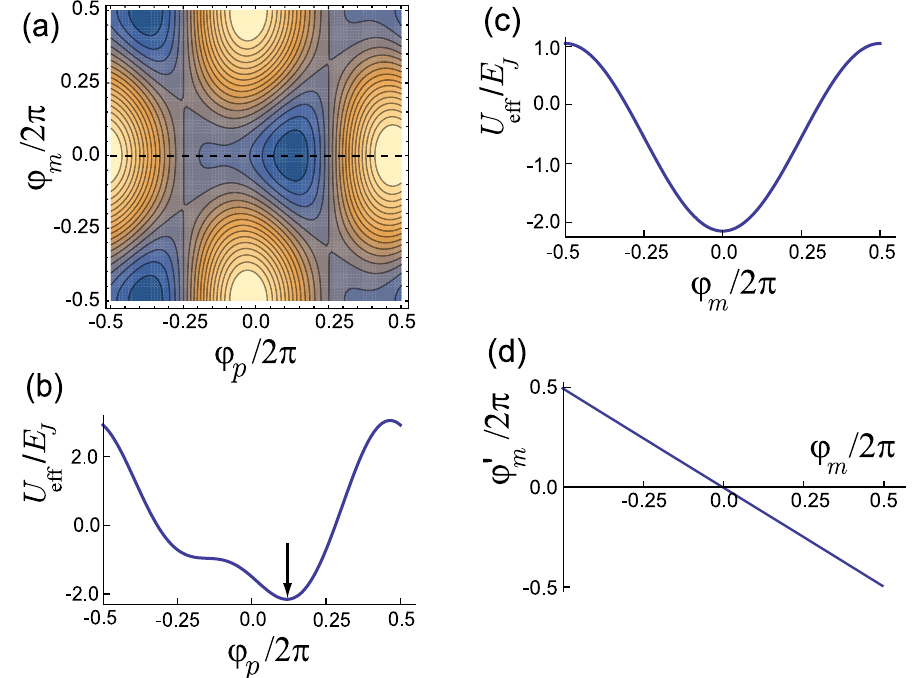
Figure 2. ( a ) Contour plot for the effective potential U eff for the system in Fig. 1b as a function of ϕ p and ϕ m for f 1 = f = 0.42, and f 2 = f 3 = 0 . ( b ) Profile of U eff along the dotted line in ( a ) for ϕ m = 0 . At ϕ p / 2 π ≈ 0.124 U eff has the minimum. ( c ) The profile of U eff for ϕ p / 2 π ≈ 0.124 shows ϕ m = 0 at the minimum of U eff . ( d ) Plot of ϕ